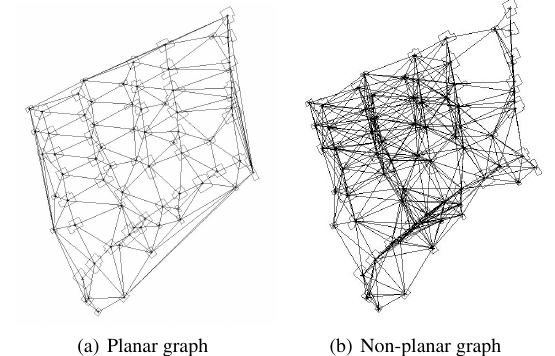
Figure 2: planar(a) and non-planar(b) graph of a residential de- tached house